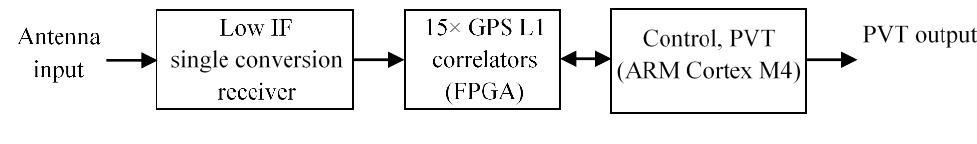
Figure 4. piNAV block scheme.